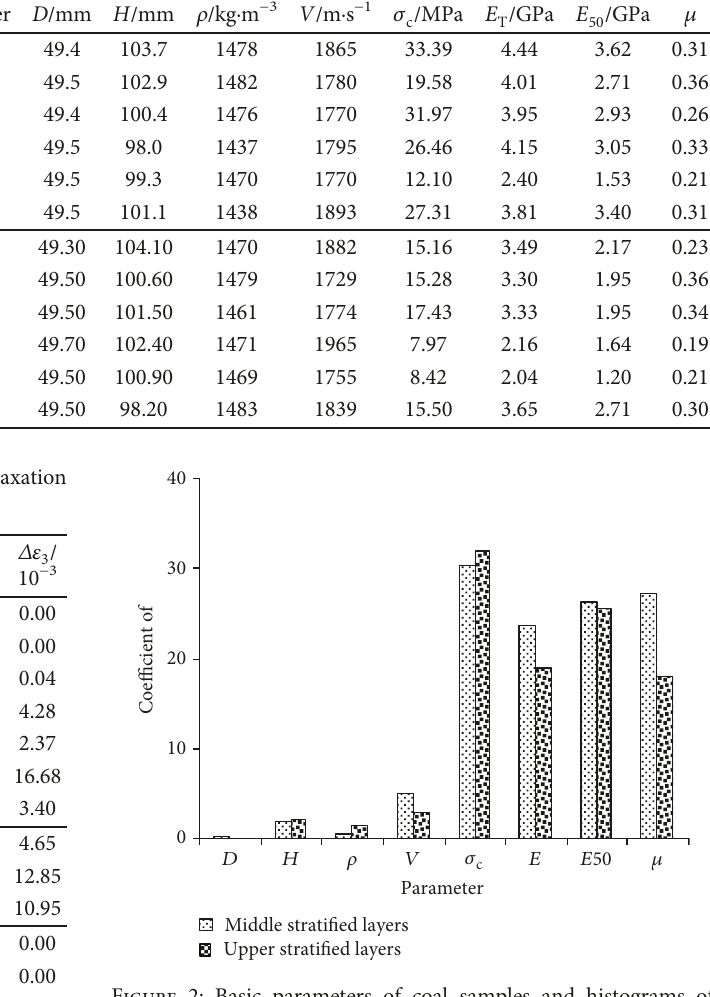
Figure 2: Basic parameters of coal samples and histograms of coe ffi cients of variation obtained from the test